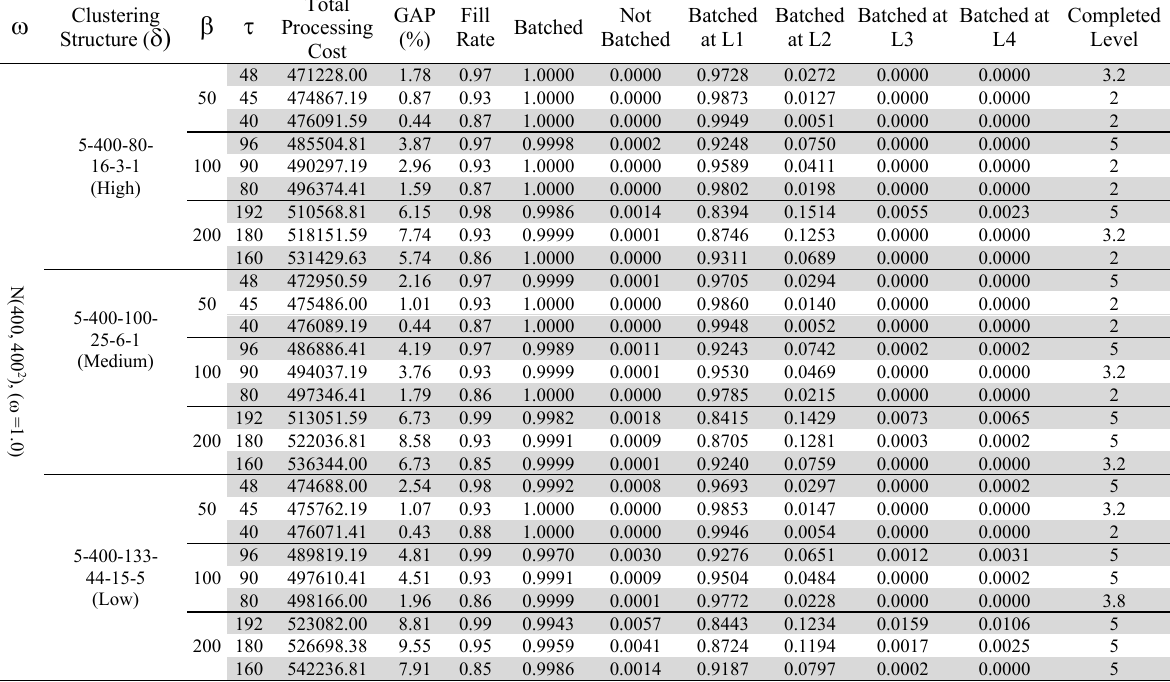
Results for demand scenario S-1 with 5-Level non-exclusive AHCS  Clustering Structure ( 